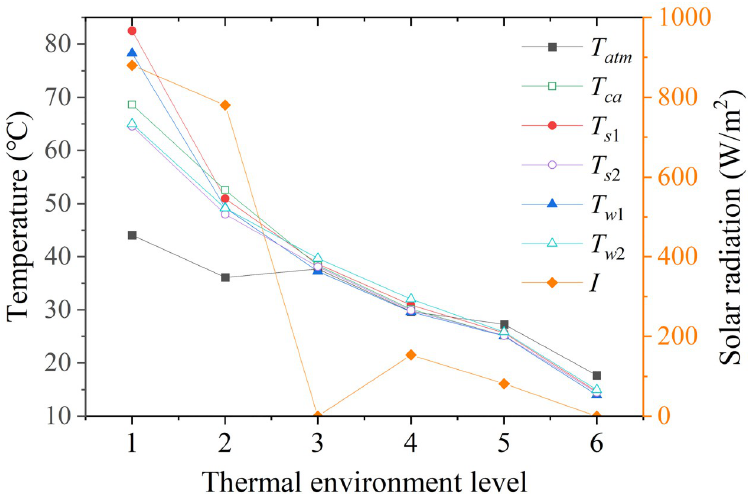
Fig 10. Characteristics of scenarios for different thermal environment levels. T temperature and relative humidity of the cabin, measured at the front and rear rows. T s 1 and T s 2 are the temperatures of the front and rear seat cushion, while T car door interior trim panel, pillars, the car roof, and